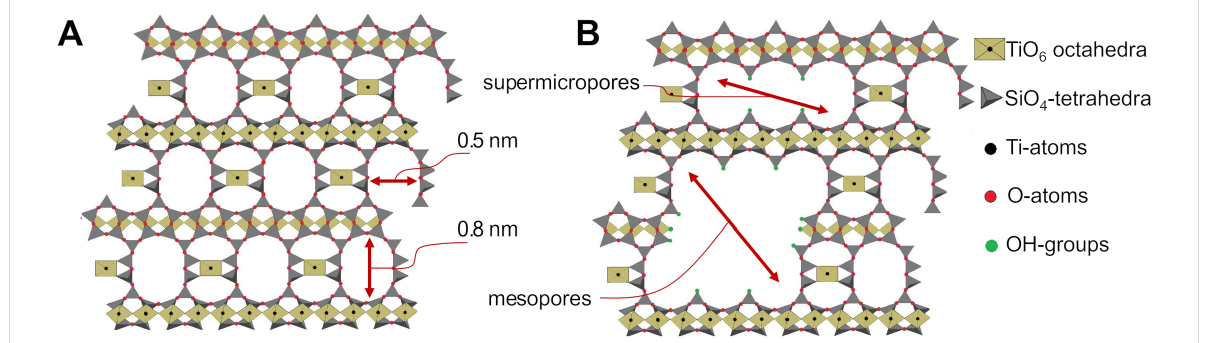
Figure 1: One of the polymorphs of the microporous ETS-10 consisting of TiO 6 octahedra and SiO 4 tetrahedra sharing oxygen atoms (A). Possible framework modification with present super-micropores and mesopores that might result from the post-synthetic treatment of ETS-10 with H 2 O 2 aqueous solution according to [26] (B).